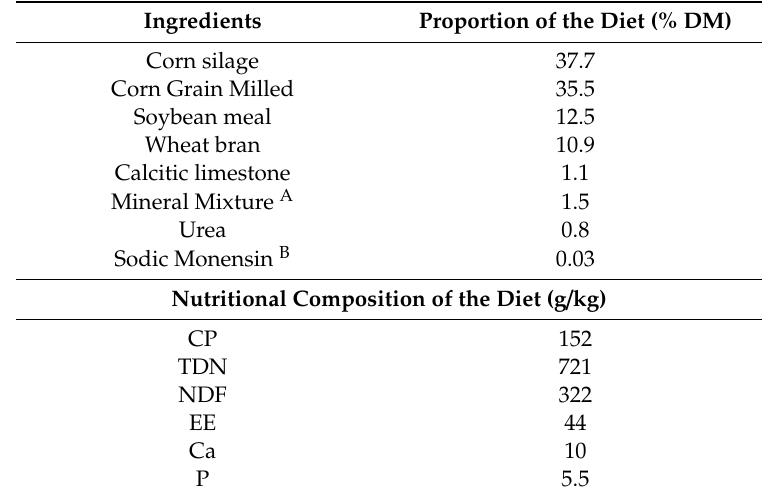
Table 2. Percentage of ingredients and nutritional composition of the diet used in the feedlot based on dry matter (%